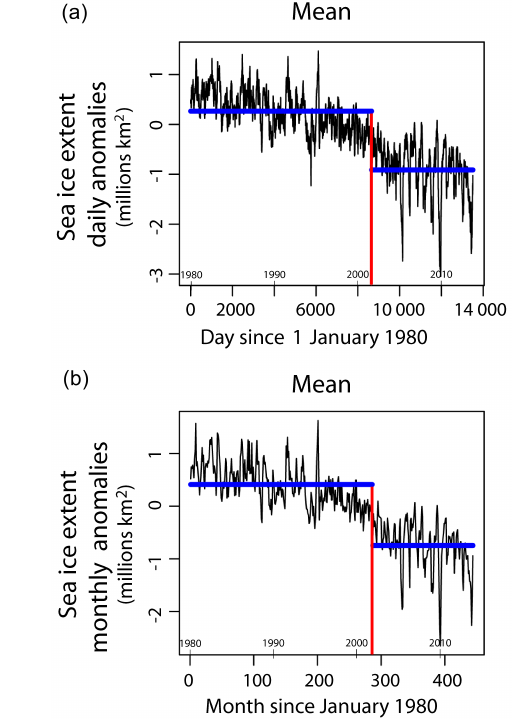
Figure 2. Example of change point detection in mean for two se- ries and one method, AMOC. Panel (a) represents the change points in the ADS series. The two horizontal lines represent the mean of the values before and after the change point identified with the AMOC method (8660th day – 22 September 2003). Those means are 0.27 and − 0.91millionkm 2 , respectively. Panel (b) represents the change points in the AMS series. The two horizontal lines repre- sent the mean of the values before and after the change point identi- fied with the AMOC method (286th month – October 2003). Those means are 0.41 and − 0.74millionkm 2 ,